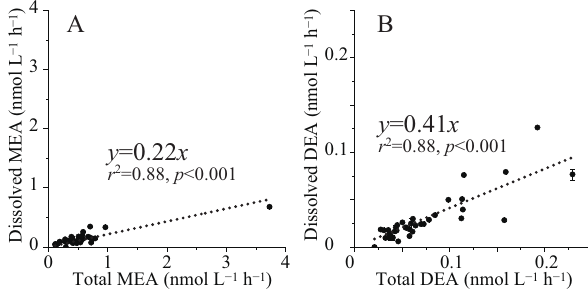
Fig. 2 Fig. 2. Phosphate esterase activities in the dissolved (<0.2µM) frac- tion vs. those in the total (unfiltered) fraction. (A) Monoesterase activities and (B) diesterase